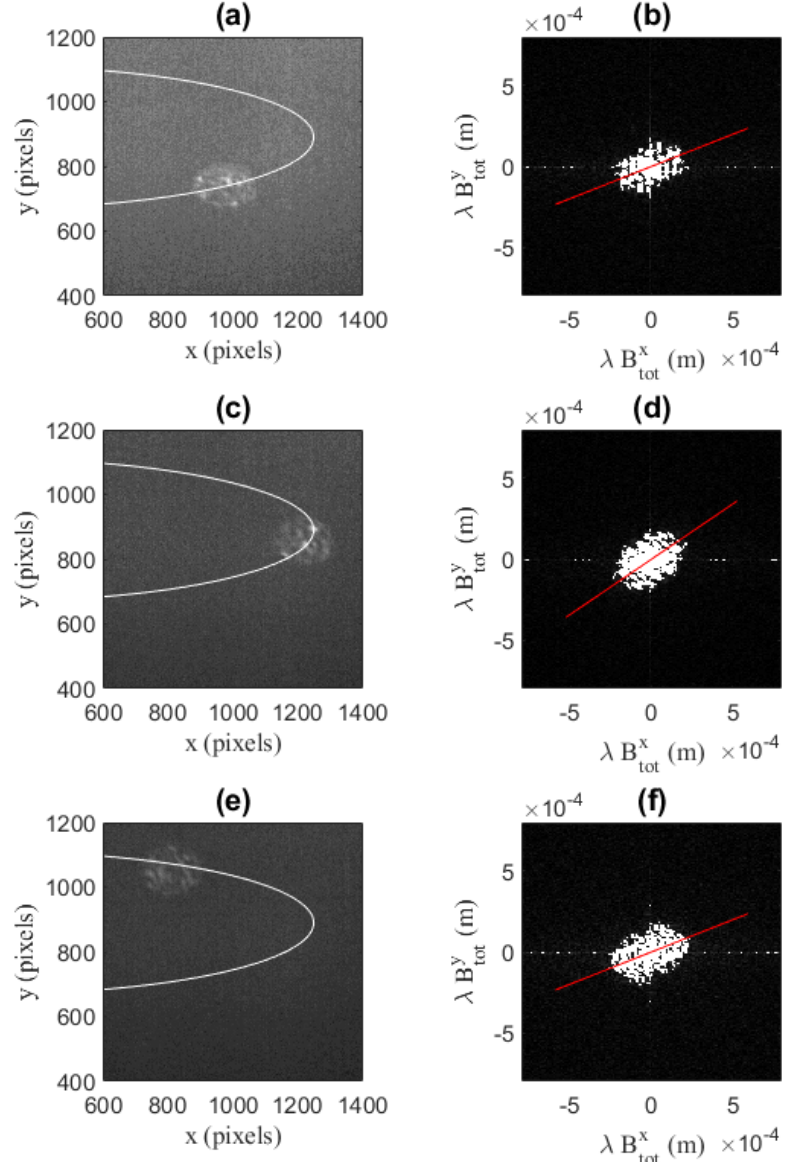
Figure 15. interferometric images of the same particle at three different times: 0.47 s ( a ), 0.57 s ( c ), and 0.77 s ( e ), and their binarized 2D Fourier transforms in ( b , d , f ), respectively. The white curves in ( a , c , e ) present the global trajectory of the particle.